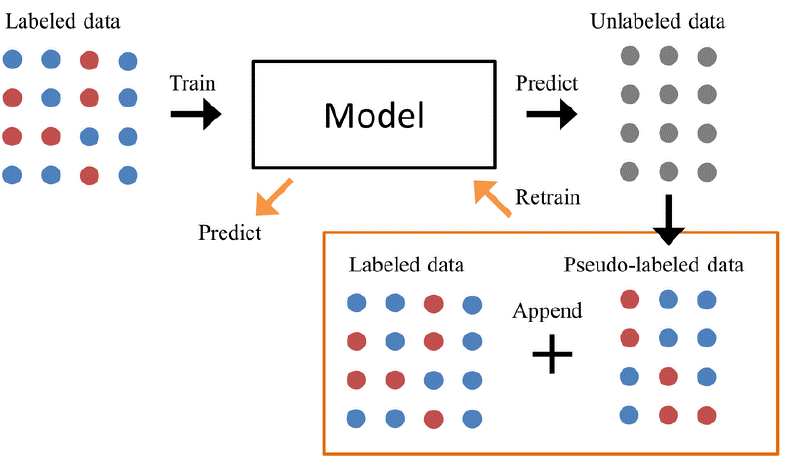
Figure 2. Traditional pseudo-labeling